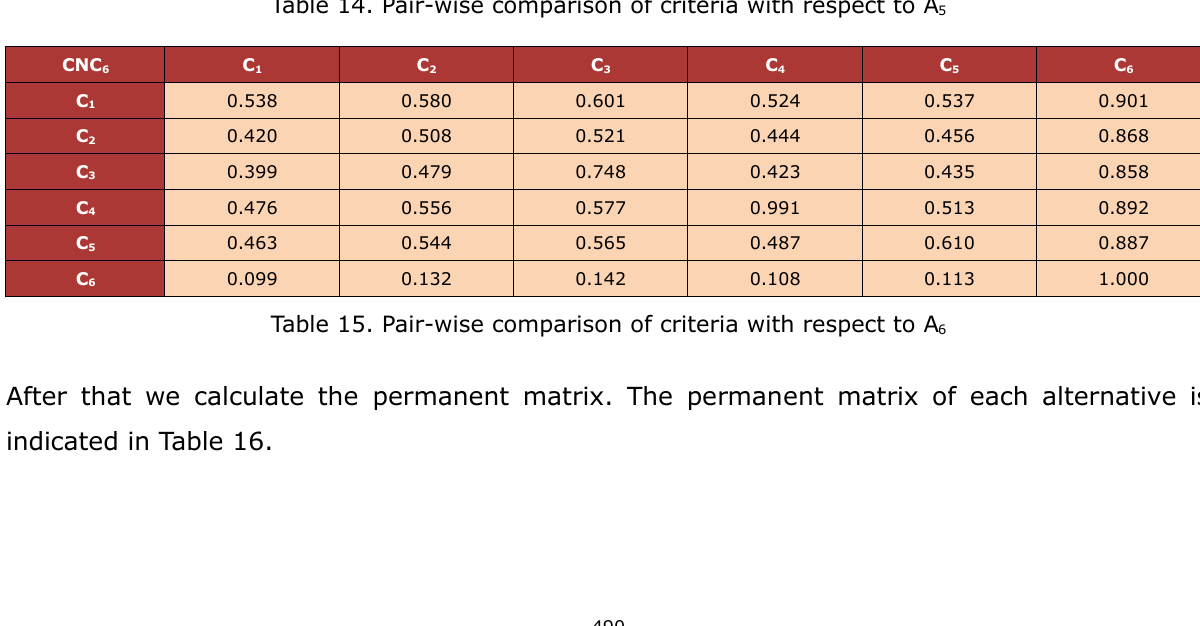
Table 14. Pair-wise comparison of criteria with respect to A 5